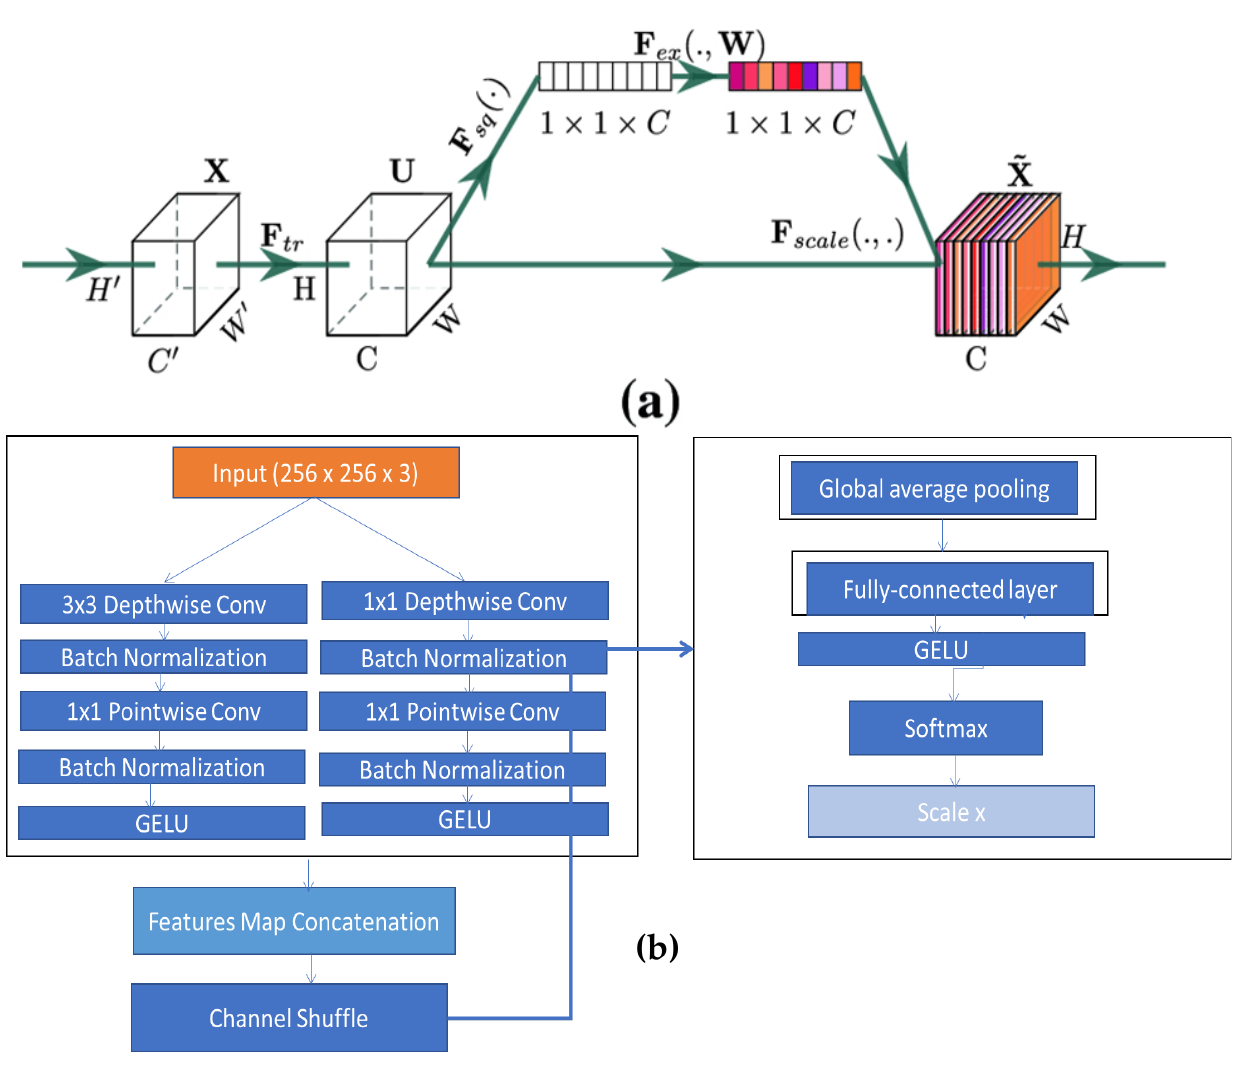
Figure 6. The modules of improved ShuffleNet by using depthwise and pointwise separable CNN along with channel shuffle operations, where ( a ) squeeze and excitation (SE) block, and ( b ) shows the proposed ShuffleNet-Light architecture.